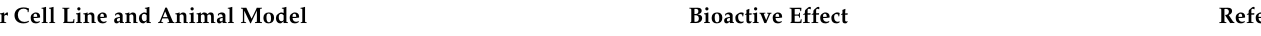
Table 5. Pharmacological effects of natural compounds in chronic lymphocytic leukemia